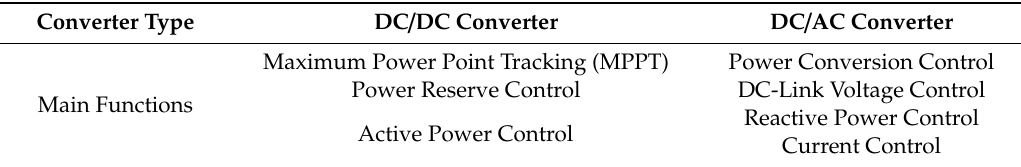
Table 1. Comparison of the control functions of the converter in the two-stage grid-connected photovoltaic virtual (PV) system.